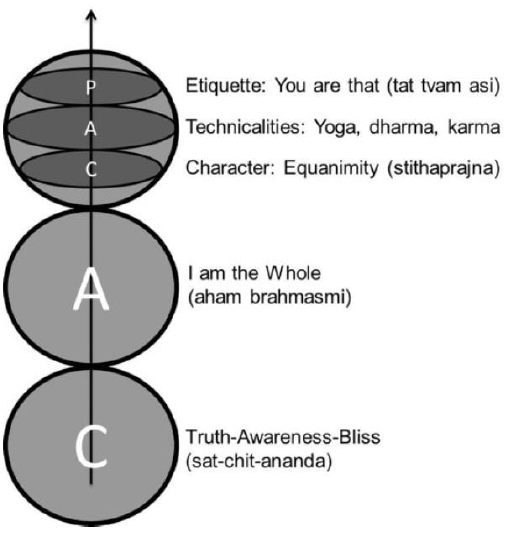
Figure 18: Spiritually Integrated